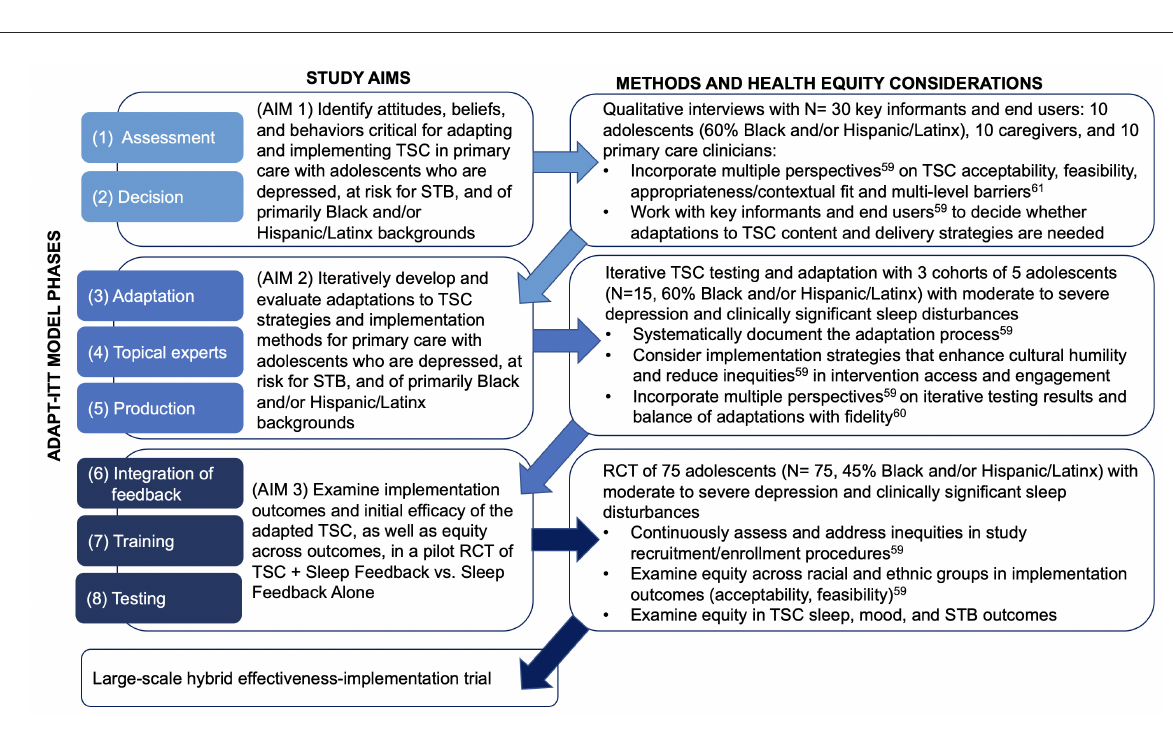
FIGURE2 ADAPT-ITT phases applied to multiphase protocol aims, methods, and health equity